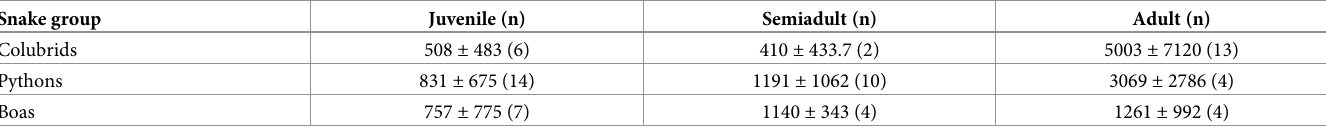
Table 7. Whole-body iron content (mg/kg DM) in the age and species groups of snakes (means ± SD; n = number of samples). Snake group